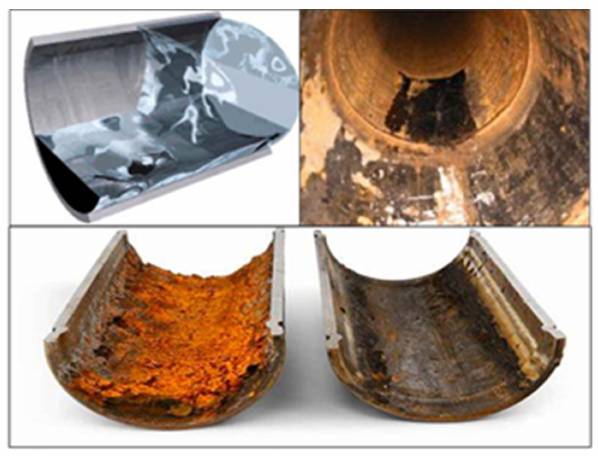
Figure 2. Schematics of some pipelines with corrosion defects. Reprinted with permission from Ref. [30]. 2021,